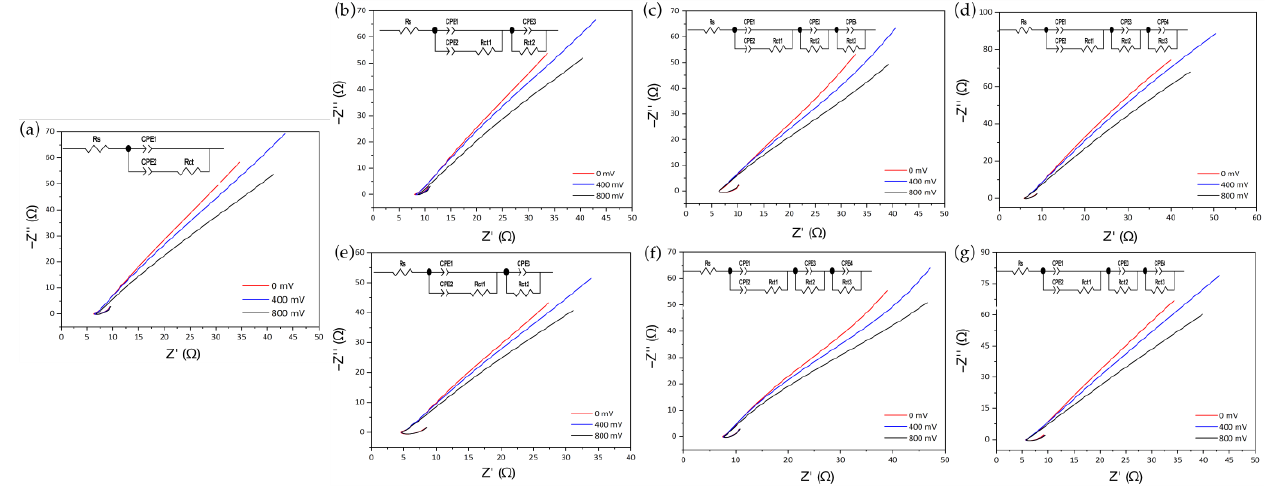
Figure 6. Nyquist plots between Z ″ y Z ′ for the graphite electrode, treated SFw membranes with and without functionalization in Hank ’ s Balanced Salt solution at different DC electrical potentials. Where ( a ) graphite electrode; ( b ) treated SFw membrane at 20 cm; ( c ) AgNPs-SFw; ( d ) AuNPs-SFw; ( e ) treated SFw membrane at 25 cm; ( f ) AgNPs-SFw; ( g ) AuNPs-SFw. At the top left of each diagram, the Randles equivalent circuit is presented.